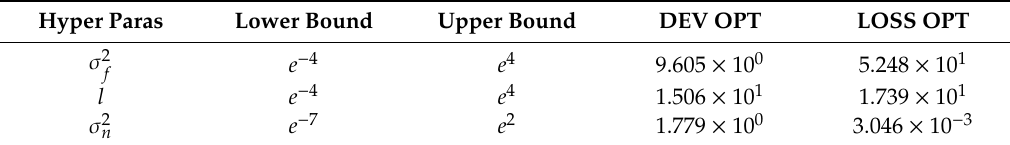
Table 4. Search domain for hyper